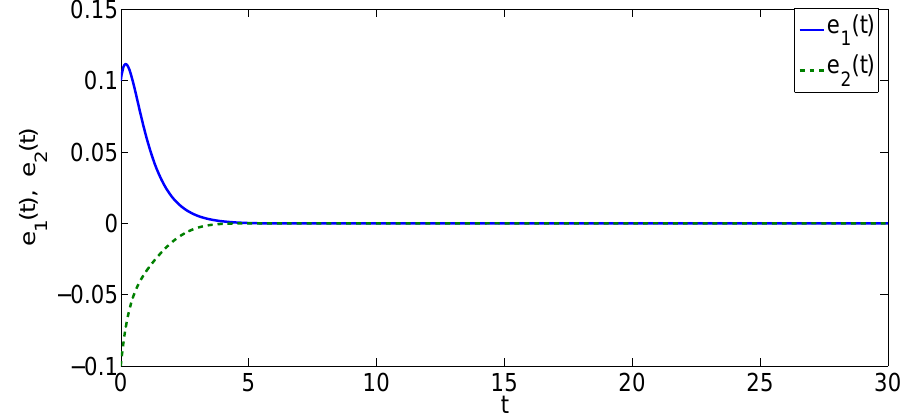
Figure 6. Evolution of synchronization errors e 1 ( t ) , e 2 ( t ) in Example